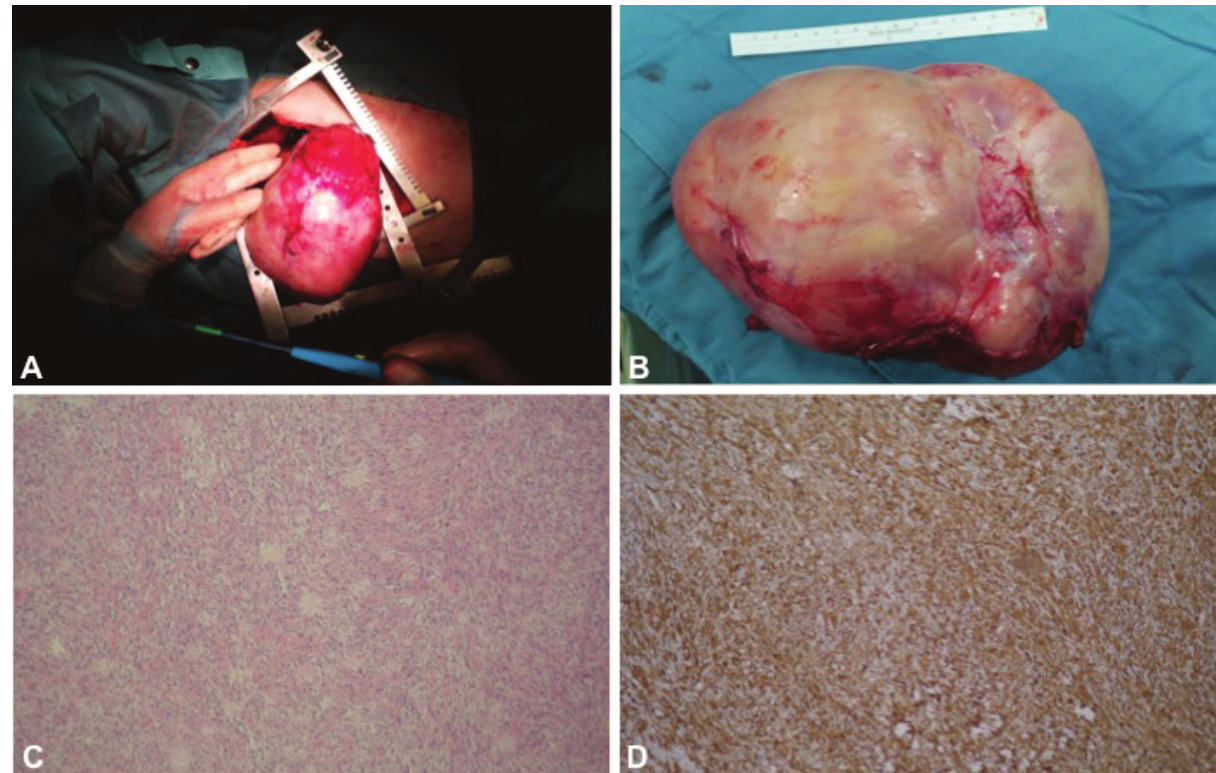
Figure 2: Giant solitary fibrous tumor of the pleura: Surgical excision (A); Surgical specimen removed (B); H&E Staining, Original Magnifica- tion x 200 (C); Immunochemistry CD34 staining, Original Magnification x 200